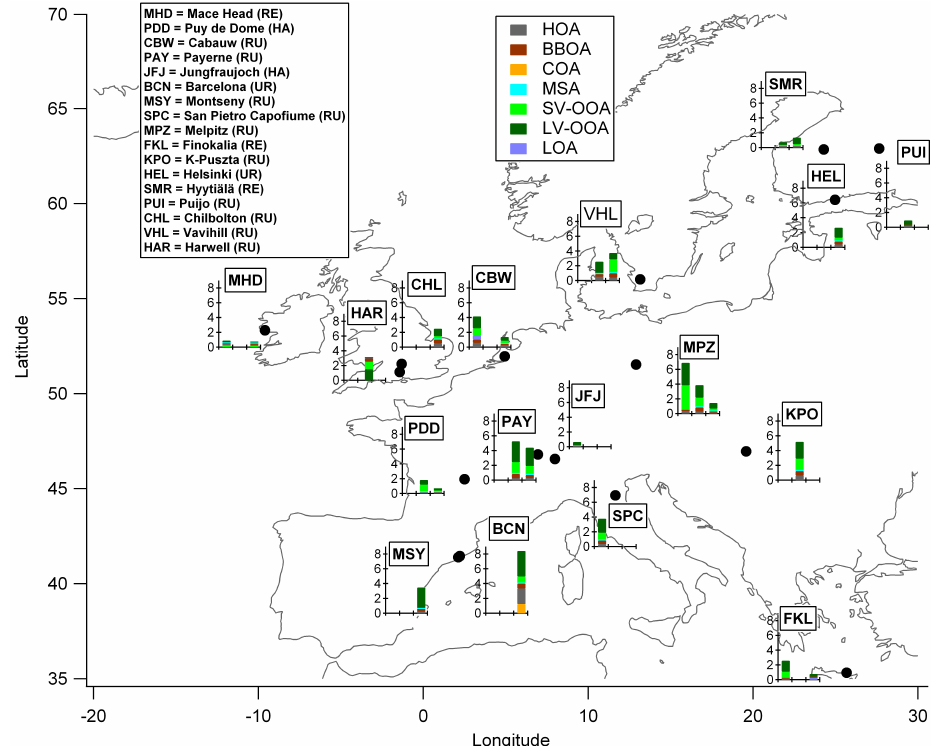
Figure 2. Measurement sites and average organic aerosol source contributions (bars). Measurement sites are classified according to their location as urban (UR), rural (RU), remote (RE) and high altitude (HA). The bar graphs report the average OA source concentrations (y-axis in µgm − 3 ) for the three measurement periods (the chronological order is from left to right: spring 2008, fall 2008 and spring 2009 campaigns, respectively). The identified OA sources are: HOA (hydrocarbon-like OA), BBOA (biomass burning OA), COA (cooking OA), SV-OOA and